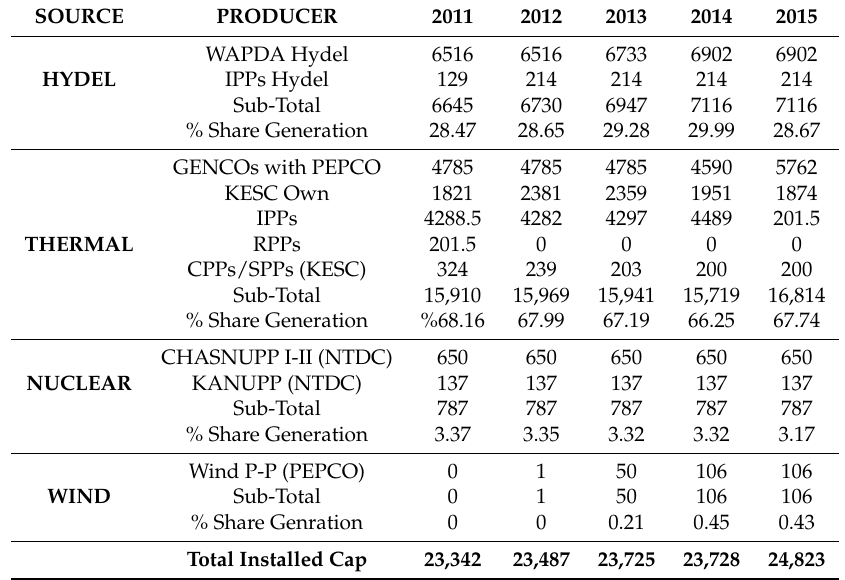
Table 1. Pakistan Electricity: Installed Generation Capacity by different resource (MW)